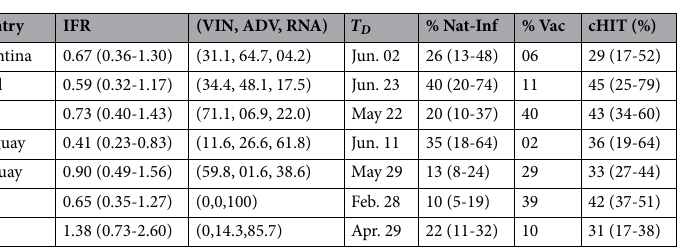
Table 1. IFR: infection fatality rate; VIN: percentage of virus inactivated vaccines; ADV: percentage of adenovirus vaccines; RNA: percentage of RNA vaccines 20–25 ; T D : decoupling time; % Nat-Inf: percentage of population naturally infected at T D ; % Vac: percentage of the population fully vaccinated at T D ; cHIT (conditional herd immunity threshold): percentage of immunized population due to vaccines and natural infections at T D . The vaccine effectiveness (VE) against SARS-CoV-2 infections was adjusted to 66% for VIN, 73% for ADV and 93% for RNA 17,18